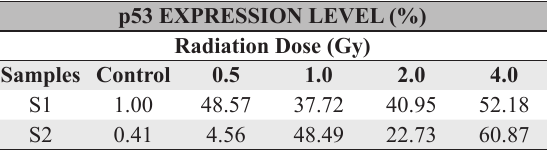
p53 protein expression levels in lymphocytes from subjects S1 and S2, for non-irradiated (Control) and